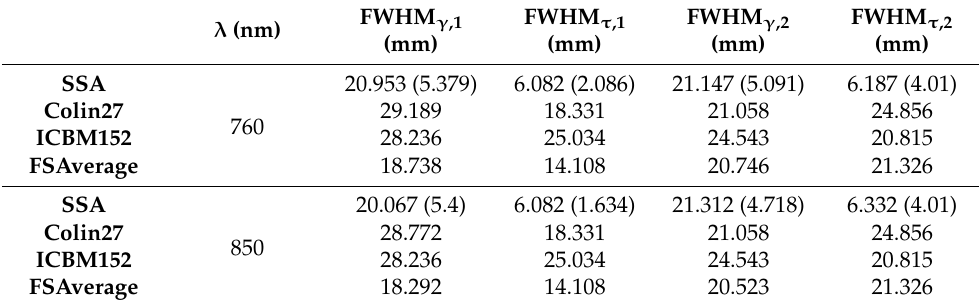
Table 5. Full width at half-maximum of SDS plots along the longitudinal (FWHM λ ) and transverse direction (FWHM τ ) at the first and second quartiles of cortical depth. Results are reported as median (IQR) for SSAs